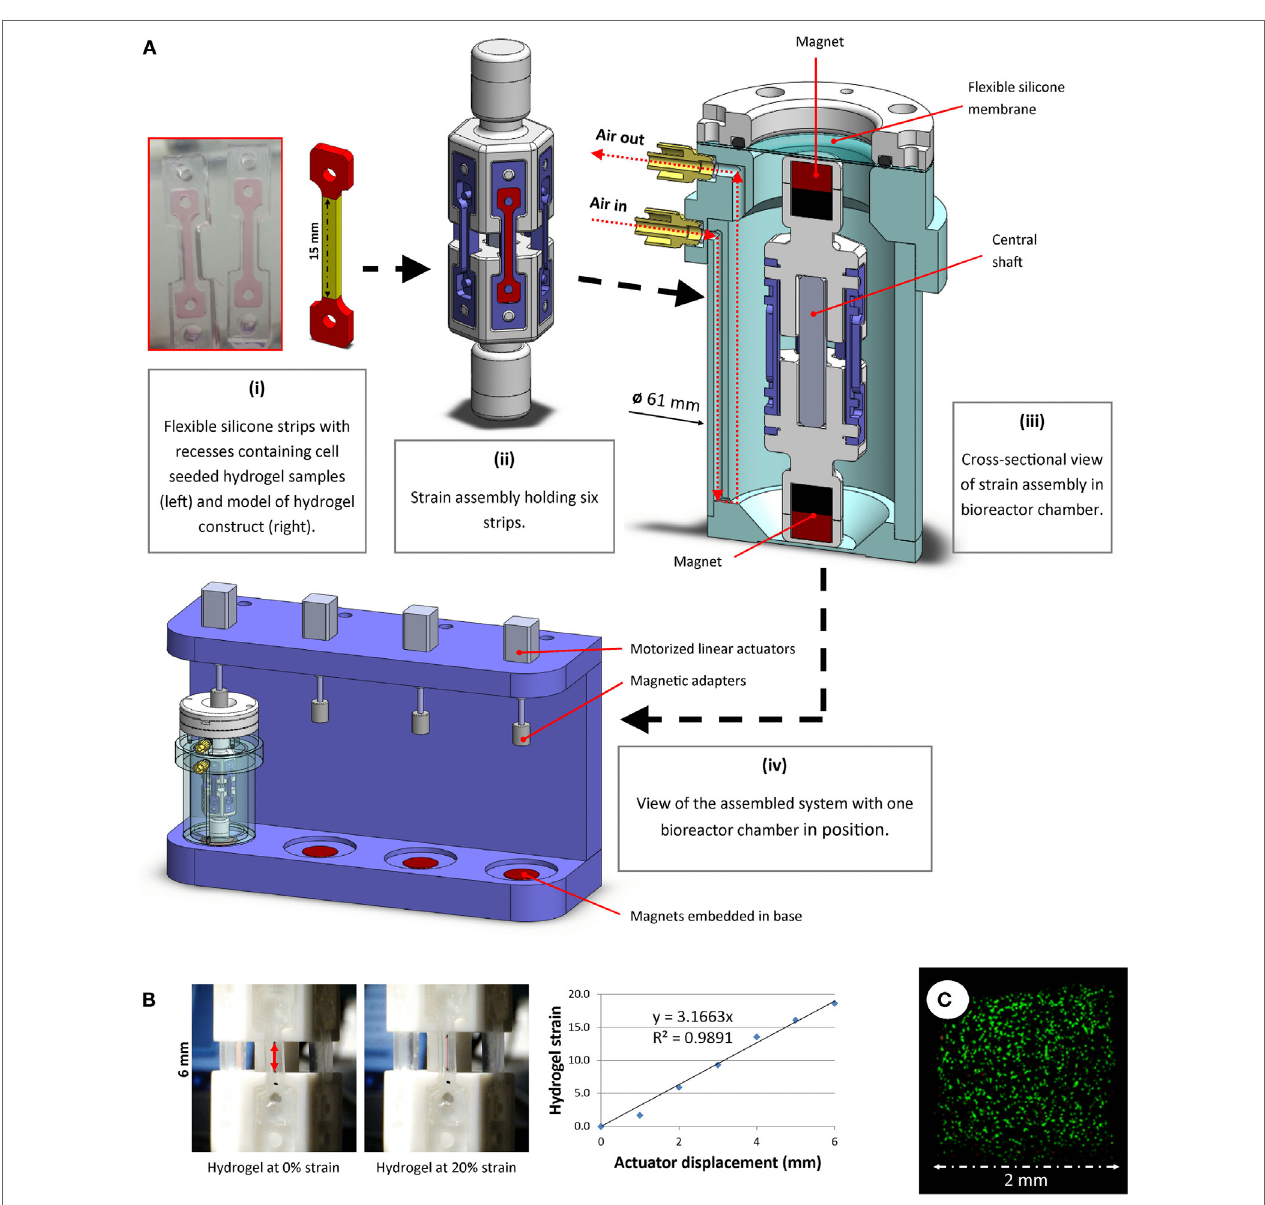
FigUre 1 | (a) A novel bioreactor system for application of uniaxial cyclic tensile strain to soft 3D hydrogels was developed. Dog-bone-shaped cell-seeded hydrogel constructs were molded in recesses within flexible silicone strips. The dimensions of the hydrogel “strain section” (highlighted in yellow) were 15 mm × 2 mm × 1.5 mm (i). These strips were mounted on strain assemblies (ii), which were then sealed into the bioreactor chamber (iii) under sterile conditions. The displacement of external actuators (iv) was aseptically transferred to accurately stretch the strips in the bioreactor using magnets, both outside of and within the chamber, connected around a flexible membrane separator. (B) Tensile testing image analyses were performed to correlate actuator displacement with hydrogel strain. Representative images and data from hydrogel strain validation image analyses are shown. (c) Multipotent stromal cells encapsulated in hydrogels